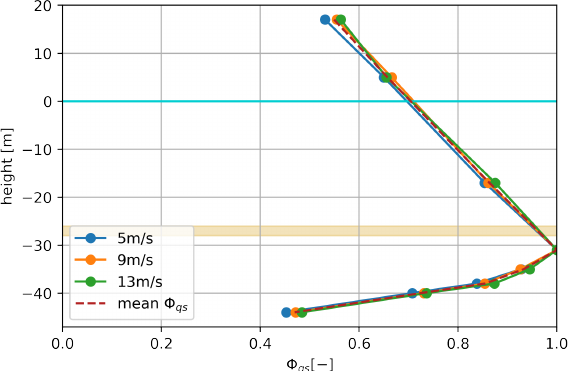
Figure 6. Extracted QS mode shape for different wind speeds. Both the water level and seabed level are indicated by horizontal